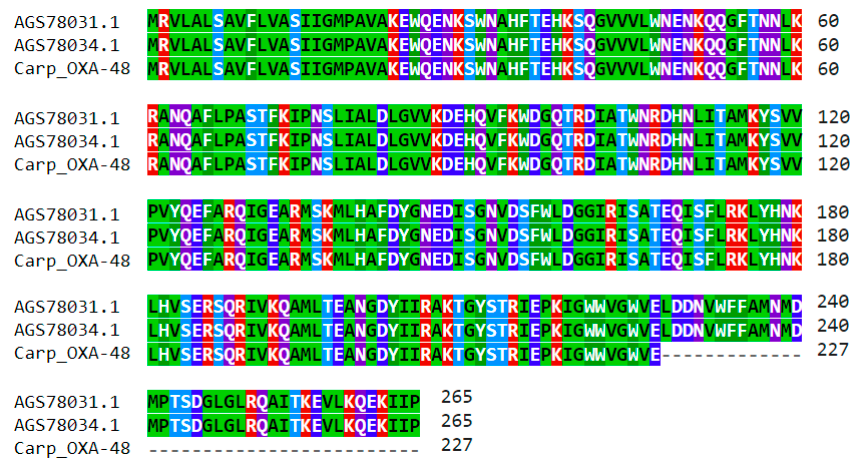
Figure 5. Multiple protein sequence alignment of the first 227 residues of an OXA-48 family class D β -lactamase encoded by the carp intestinal contig (Table 1) with the OXA-48b β -lactamases of S. xiamenensis strains IR24 and IR33, with NCBI Accessions AGS78031 and AGS78034 [46].